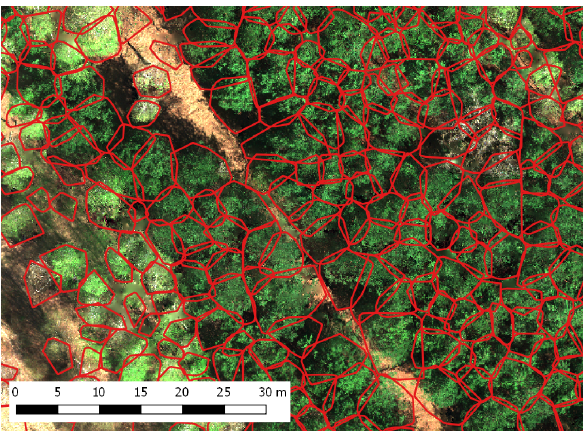
Figure 2. Superimposed tree polygons on the